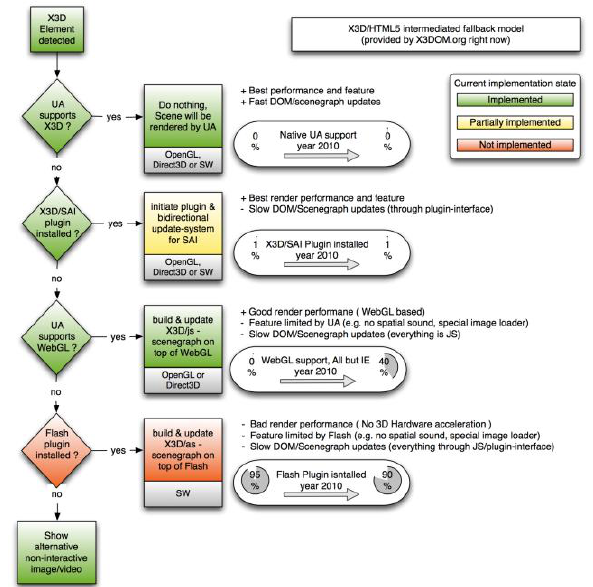
Figure 5. Fallback model: depending on the X3DOM profile and current browser environment, the system automatically chooses the appropriate backend rendering system.